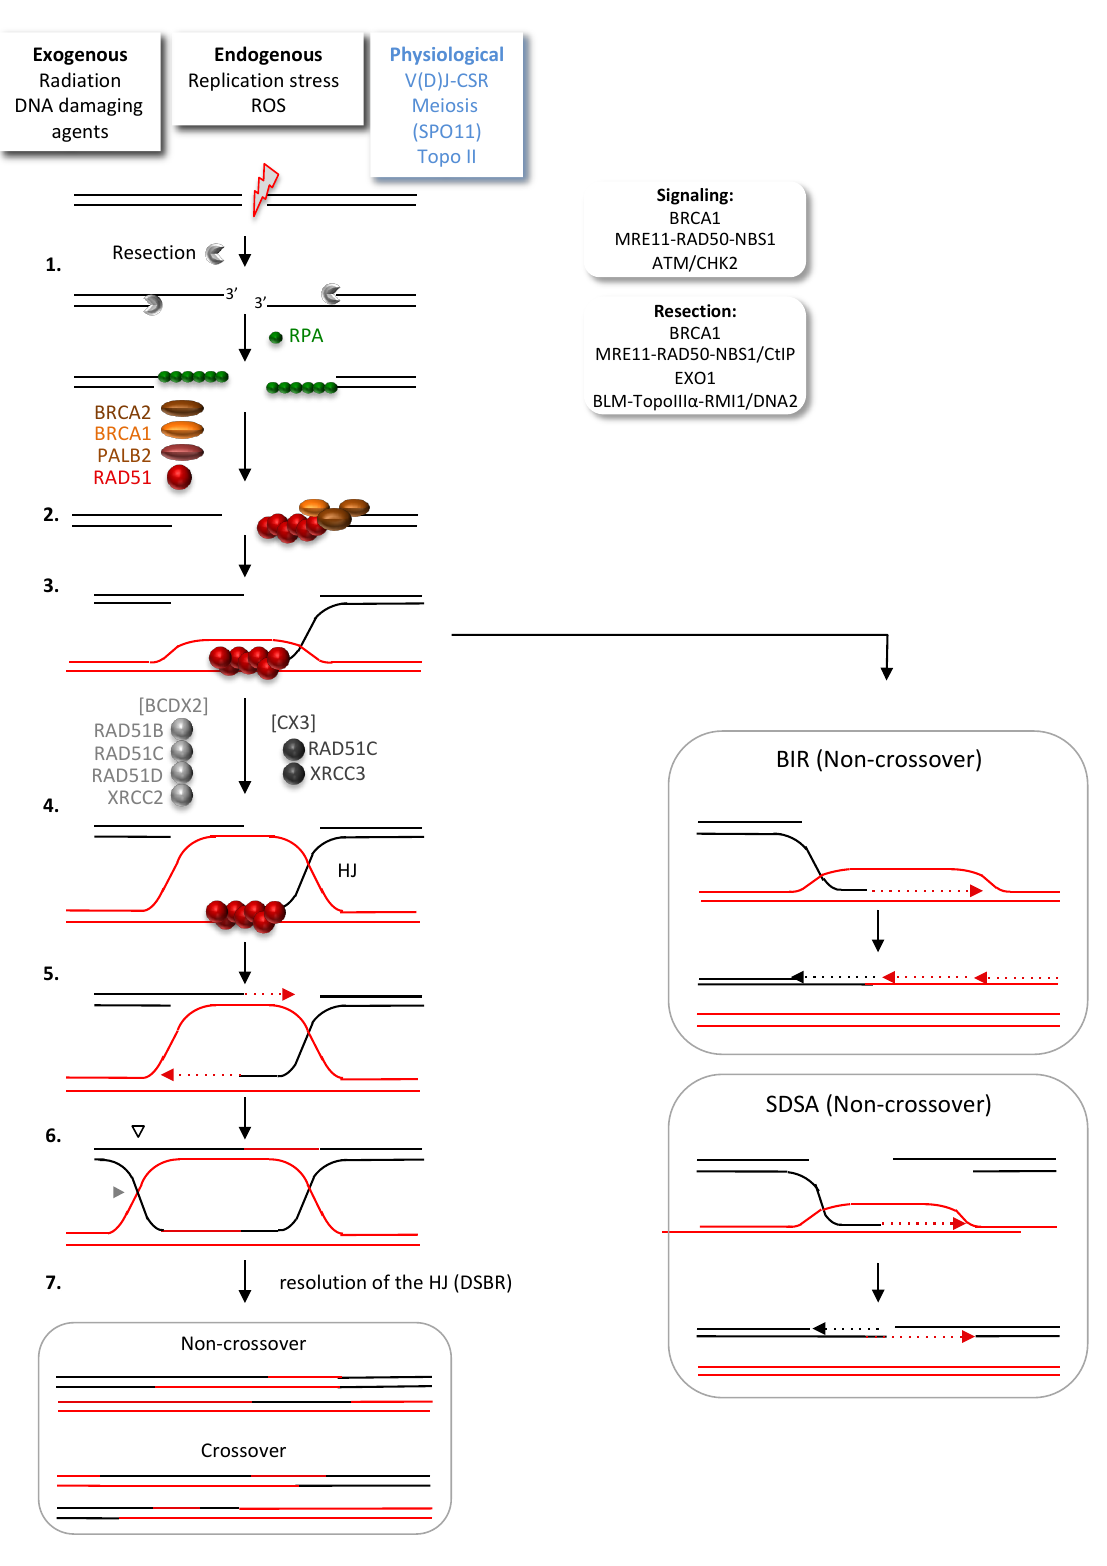
Figure 1. HR-mediated double-strand break repair. Different sources, exogenous, endogenous, or physiological, can generate DSBs, which are signaled by MRE11/RAD50/NBS1 (MRN) and the axis of kinases ATM/CHK2. 1. The resection of the DSB generates 3’-single-stranded DNA (ssDNA), which is coated and protected by the replication protein RPA. The resection is initiated by MRN/CtIP then EXO1 or the association of the helicase BLM (in complex with TopoIII and RMI1) with the endonuclease Dna2. 2. BRCA2/PALB2 in mammals (RAD52 in yeast) replace RPA with RAD51, which forms a structured filament. The BRCA2-deficient cells can promote the homology-